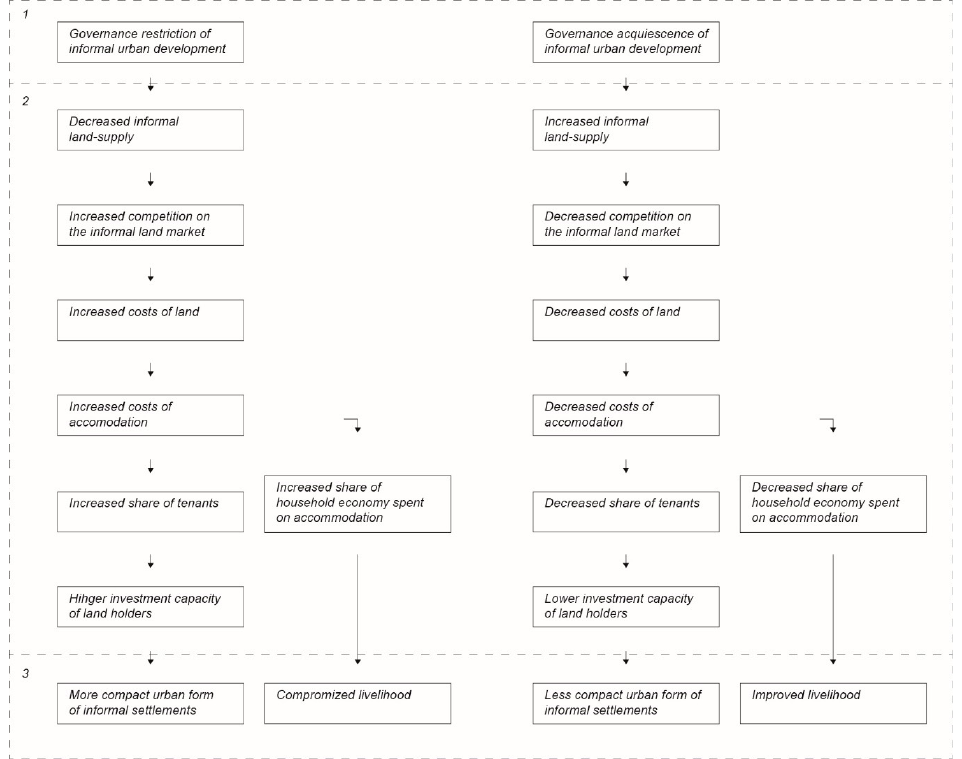
Figure 4. Graphic representation of the Hypothesis on Informal Land Supply, Livelihood, and Urban Form in Cities in sub-Saharan Africa: 1: governance practice, 2: market mechanisms, and 3: household conditions and urban